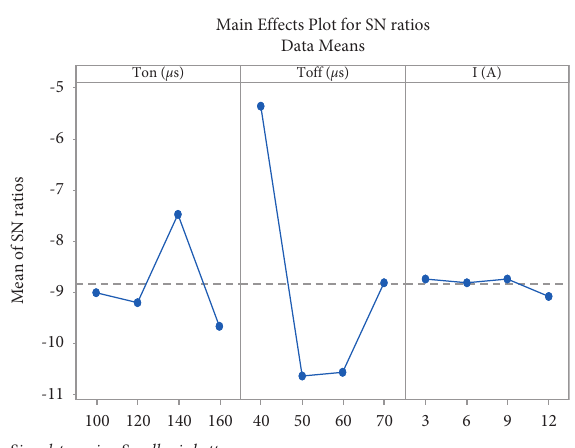
Figure 3: Means of SN ratio for